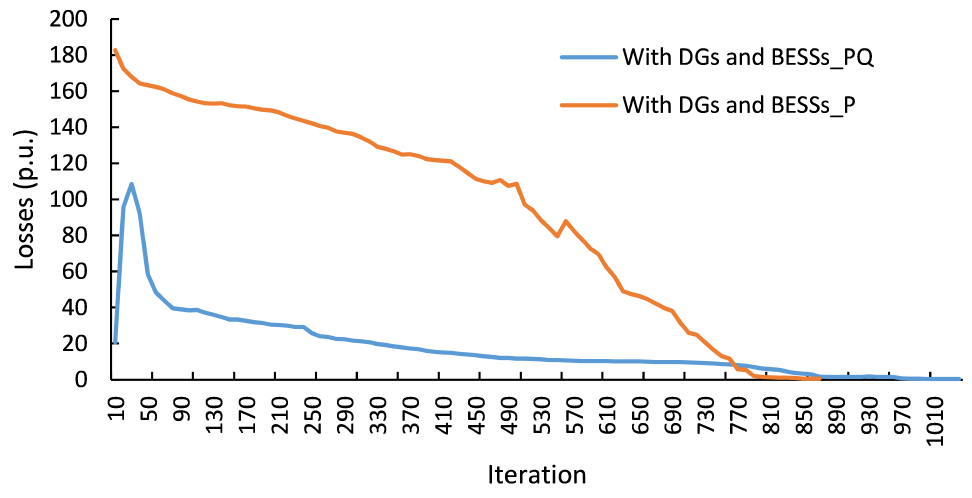
Figure 17. Convergence analysis to the 141-bus test